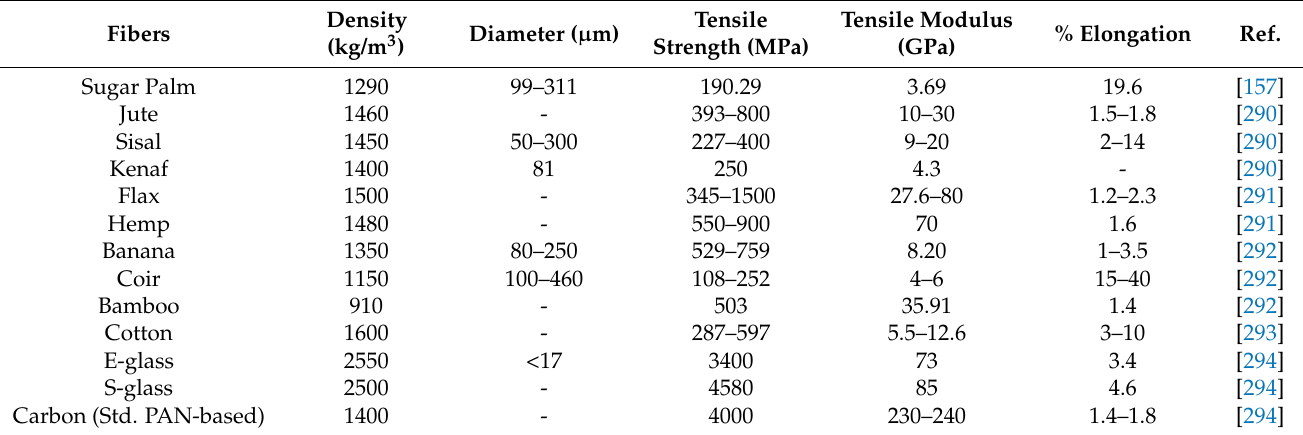
Table 3. Tensile properties of natural and inorganic